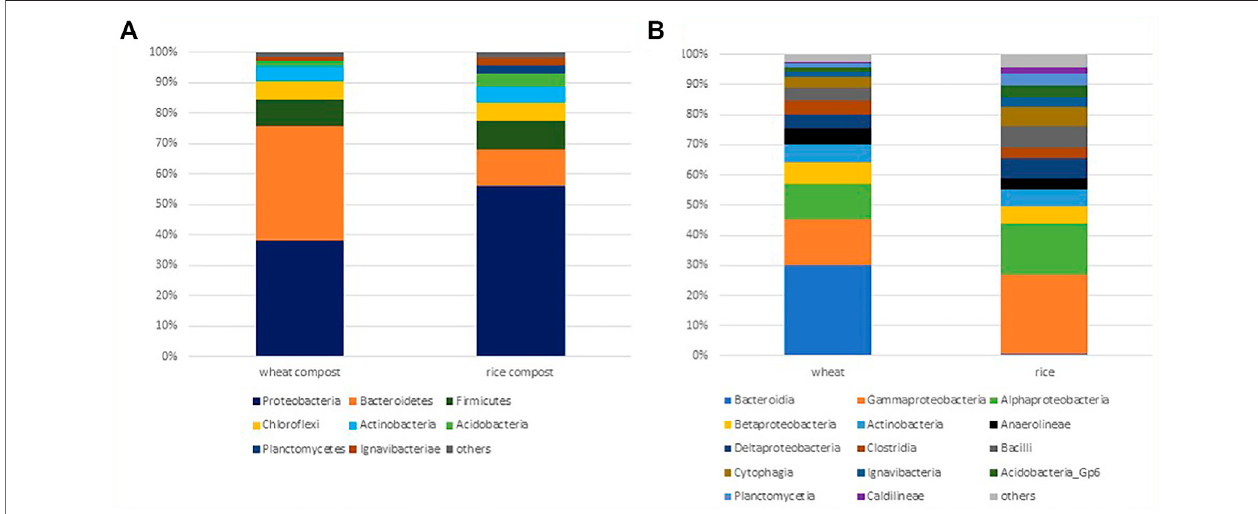
FIGURE1|(A) Phylumlevel. (B) Classlevelrelativeabundanceofmajorbacteria(representedby > 0.5%sequences)detectedby16SrRNAgeneanalysisinwheat and rice compost